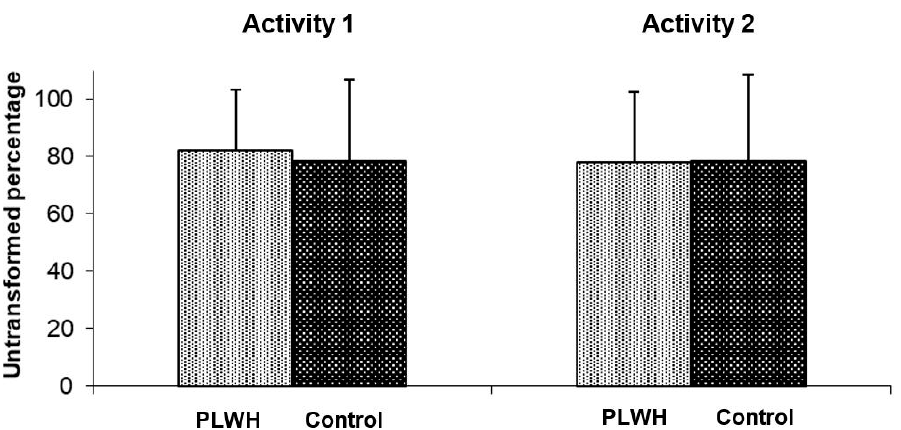
Figure 3. Activity-based prospective memory performance in persons living with HIV (PLWH) and controls. Interaction between within- and between-subject factors on activity-based prospective memory performance. Means and standard deviations are shown.